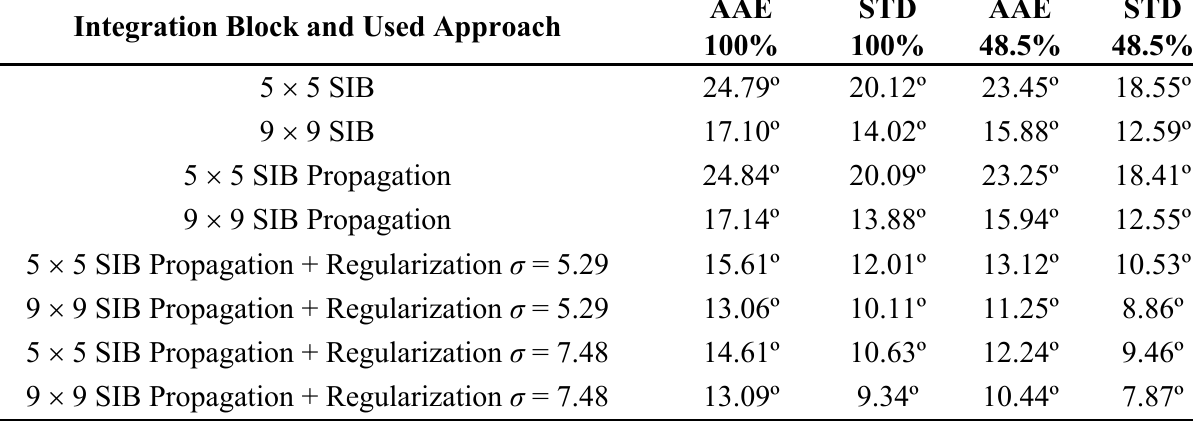
Table 3. Average angular error (AAE) and standard deviation (STD), in Yosemite sequence (without clouds), with the different proposed approaches and densities on Eye-RIS